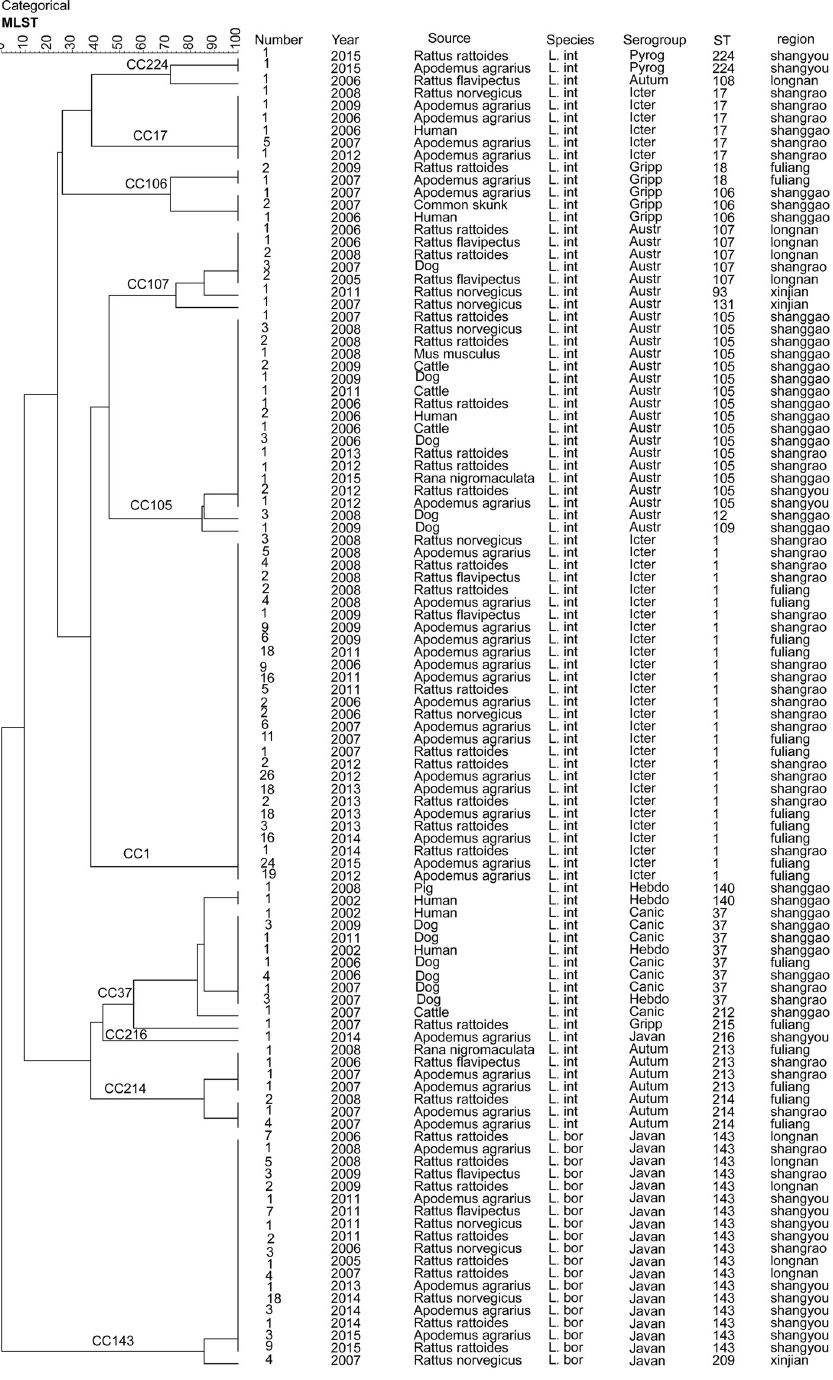
Fig 3. UPGMA dendrogram indicating the diversity of 401 Chinese pathogenic Leptospira strains of Jiangxi determined by MLST analysis. Groups were defined by a similarity of 60%. The dendrogram displays that the 401 Chinese Leptospira strains belonged to seven major clades and the remaining isolates were dispersed as unrelated singletons. (Austr: Australis, Autum: Autumnalis, Canic: Canicola, Gripp: Grippotyphosa, Hebdo: Hebdomadis, Icter: Icterohaemorrhagiae, Javan: Javanica, Pyrog: Pyrogenes, L . int : L . interrogans . L . bor : L . borgpetersenii